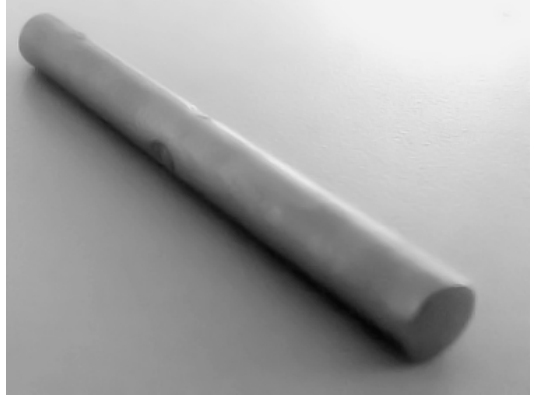
Figure 6. Sample after HIP treatment. Relative density as a function of temperature is represented for the pure nickel bars sintered for 1 h under different atmospheres in Figure 7. In all cases, a significant increase in the densification occurs between 1300 and 1325 °C. For higher temperatures, melted zones were detected on the surface of the sintered pieces in all the atmospheres used. This behavior is in accordance with the phase diagram of Ni-C, which can be consulted in ASM Handbook [27]. This phase diagram reveals that at the carbon content of the brown parts (2.6 wt.%) the formation of the liquid phase takes place at a lower temperature due to the eutectic point at 1326.5 °C between both species. For this reason, a maximum sintering temperature of 1325 °C has been selected in all cases to avoid the uncontrolled melting of the parts. At this sintering temperature, similar relative density values (around 93.5%) have been obtained after sintering in the selected atmospheres for 1 h.